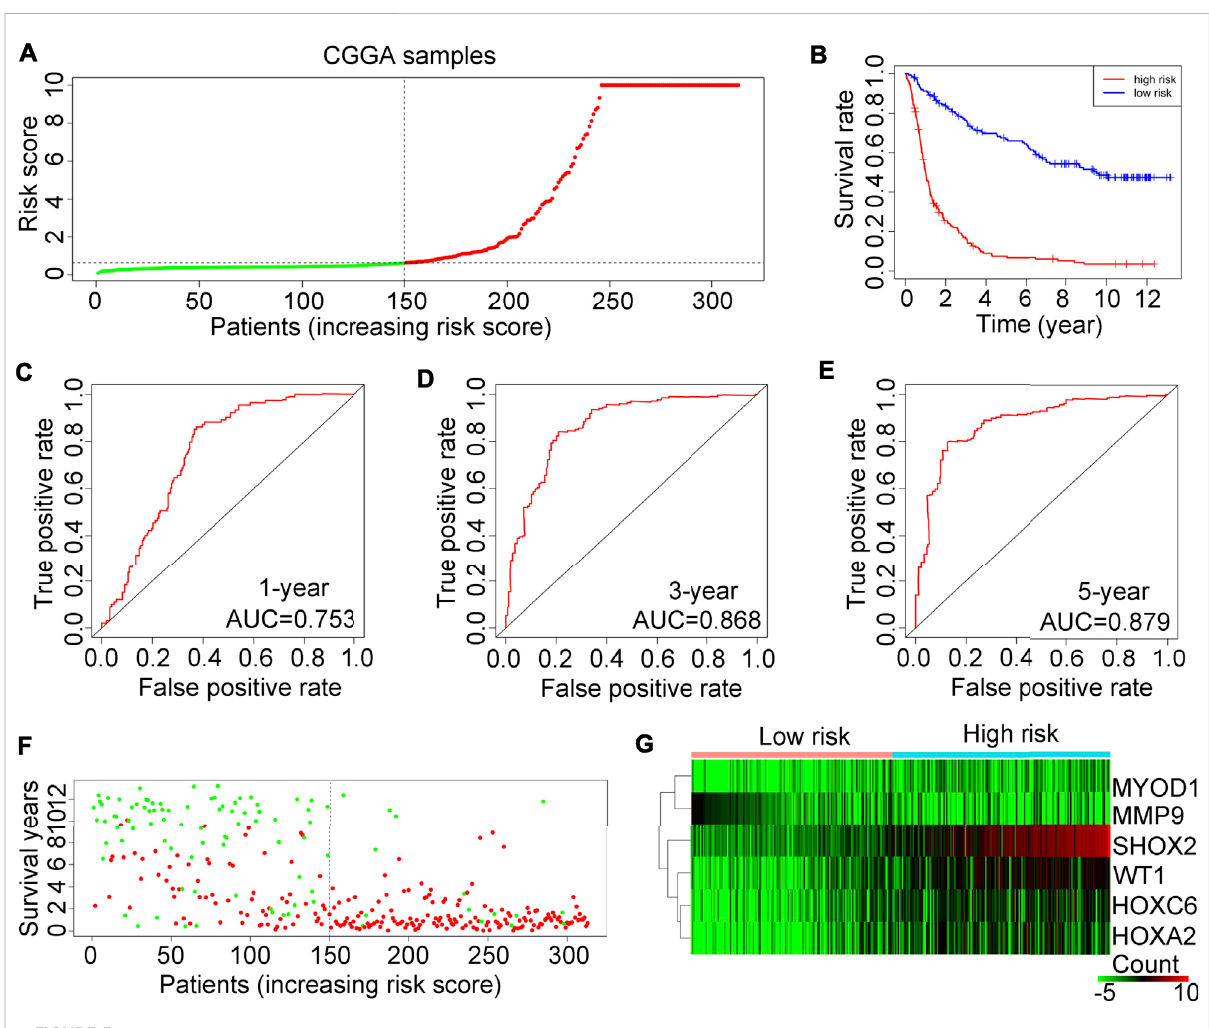
FIGURE 5 Examination of the risk model in the CGGA training cohort. (A) Glioma samples in the CGGA were divided into low-risk or high-risk groups. (B) Kaplan-Meier plot analysis of the overall survival rate in low-risk and in high-risk patients with glioma in the CGGA. (C – E) Receiver operating characteristic (ROC) curves showing the diagnostic value of the risk model for the 1-year, 3-year and 5-year survival rates of patients with gliomas in the CGGA. (F) Survival time and status of each glioma patient in the CGGA cohort. (G) Expression levels of MYOD1, MMP9, SHOX2, WT1, HOXC6 and HOXA2 in glioma tissues from patients with high-risk or low-risk scores in the